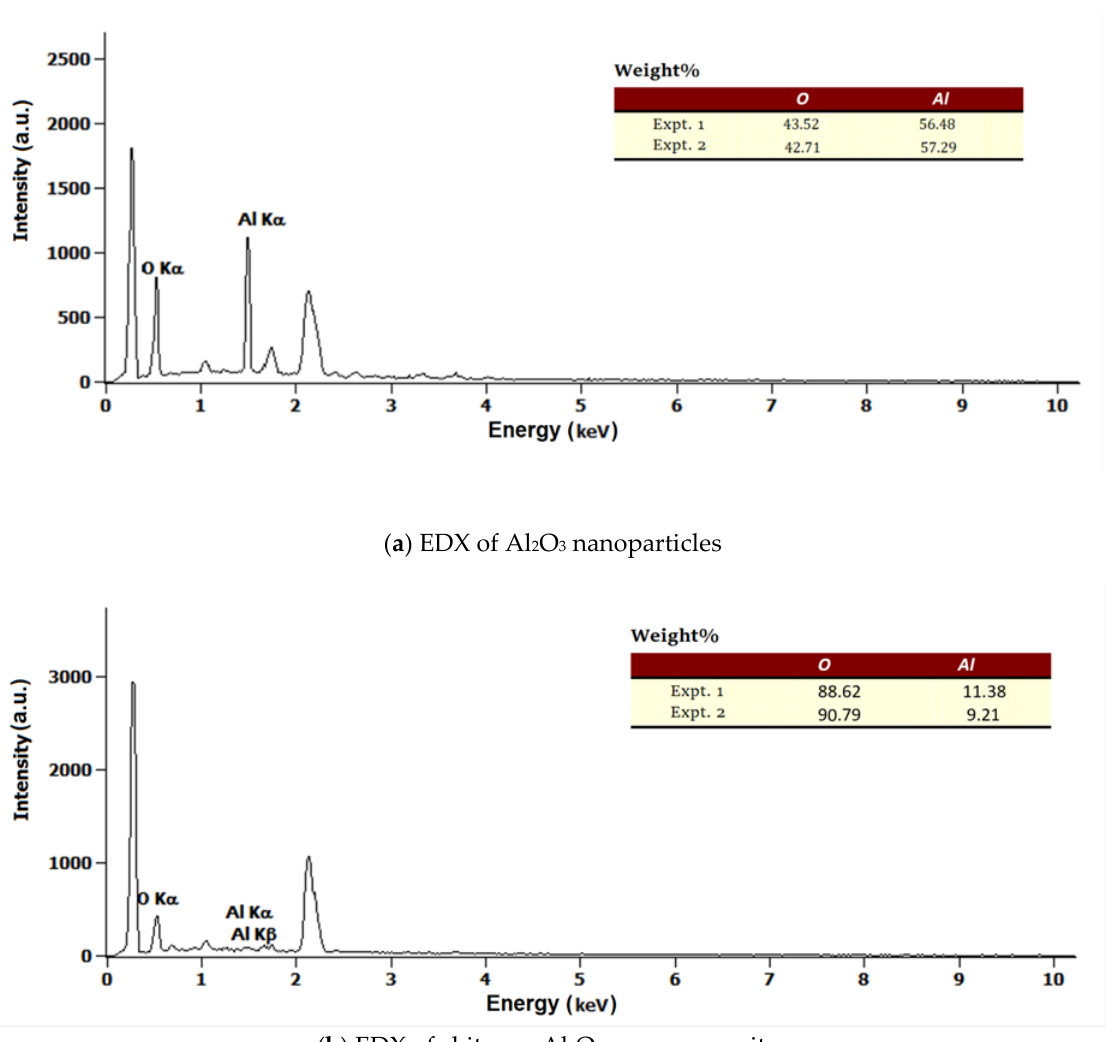
Figure 4. EDS of chitosan- Al 2 O 3 nanocomposites ( b ) as compared to that of Al 2 O 3 ( a ).